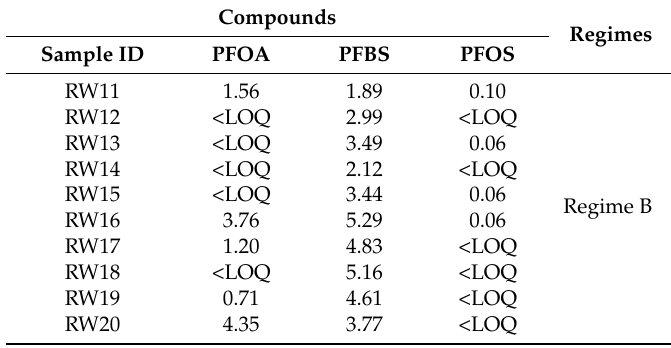
Table 3. Concentration of PFOA, PFOS and PFBS in river water (ng/L). Table 2. Cont.